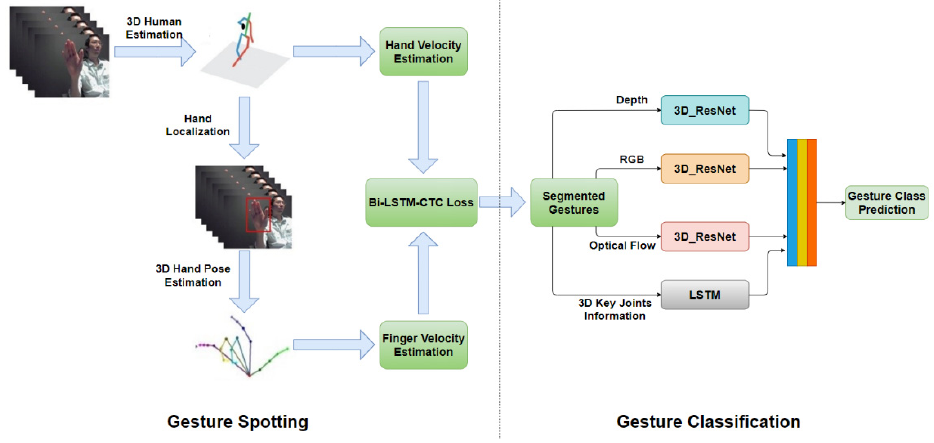
Figure 1. Gesture Spotting-Classification Module.